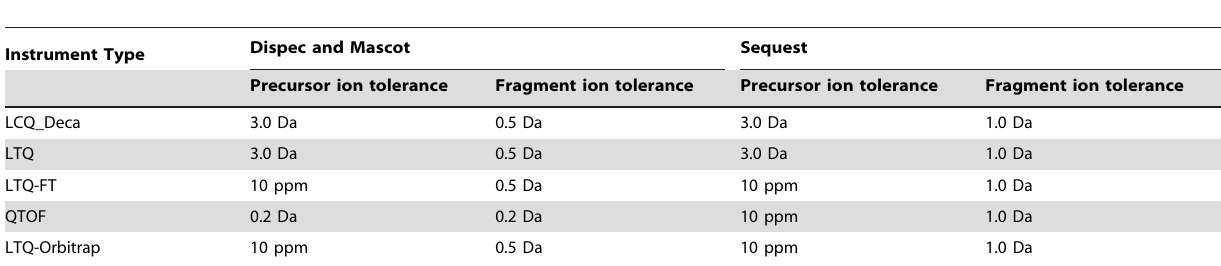
Table 1. The parameters of precursor and fragment ion tolerance according to instrument type.